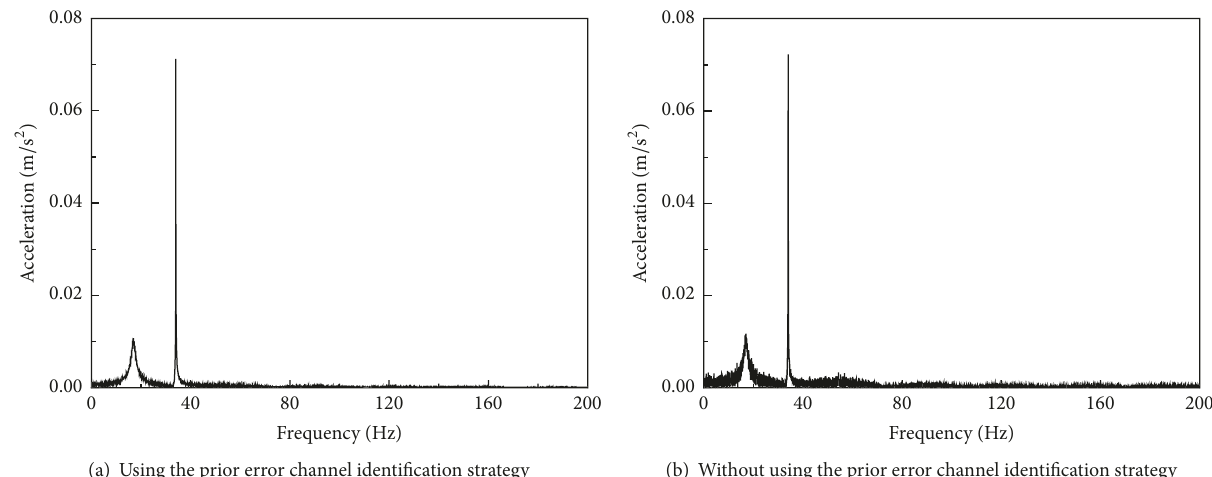
Figure 10: Frequency spectrum of controlled point of proposed